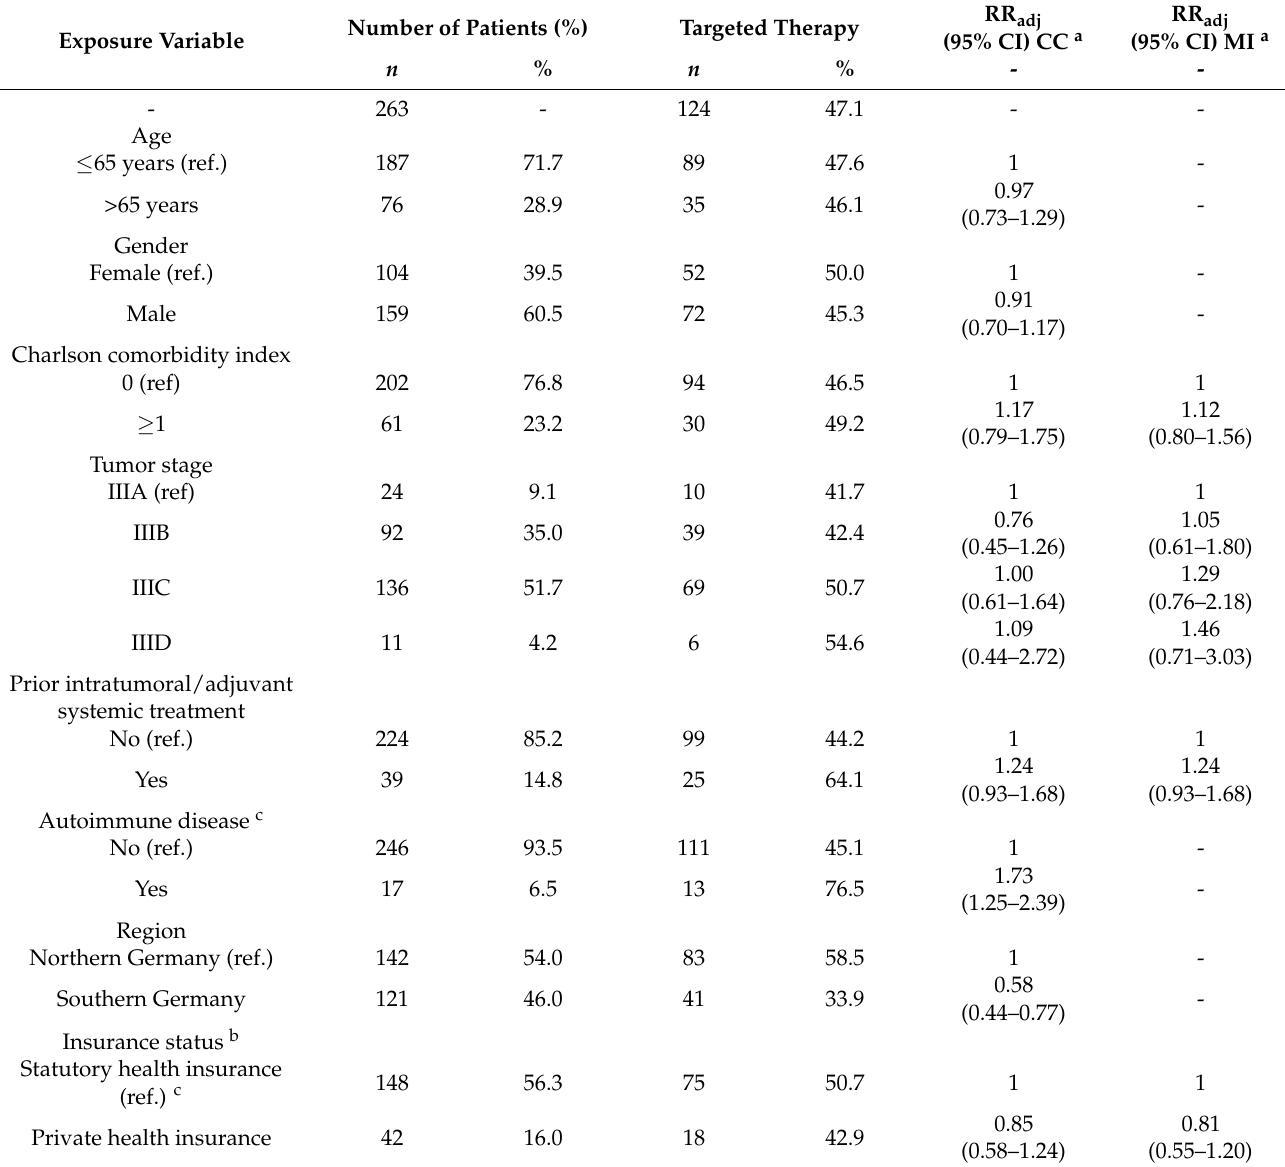
Table 5. Adjusted relative risks with 95% confidence intervals for the associations between various exposure variables and decision for targeted therapy in BRAF -mutant patients: Results from log-binomial regression models with complete case analysis and use of multiple